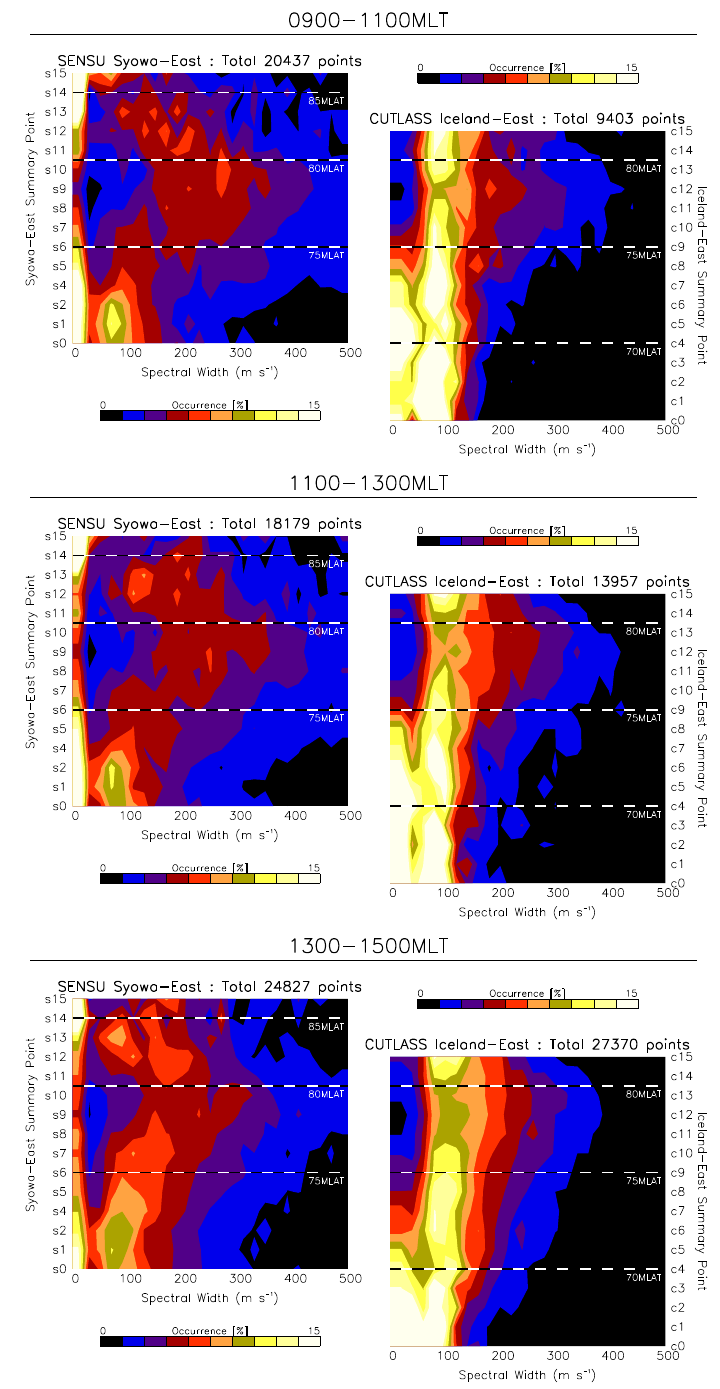
Fig. 5. Variation of spectral width distribution with magnetic local time. The distributions are shown in same form of contour as Fig. 4 for three magnetic local time sectors: prenoon sector (09:00–11:00MLT; top panel), noon sector (11:00–13:00MLT; middle panel), and postnoon sector (13:00–15:00MLT; bottom panel), respectively.